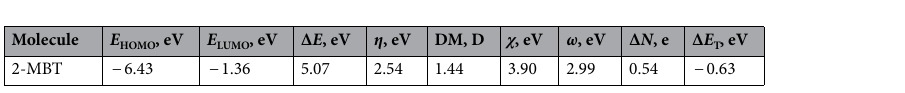
Table 8. The B3LYP/ 6–311 + + G(2d,2p) chemical descriptors of the studied 2-MBT in the aqueous phase.